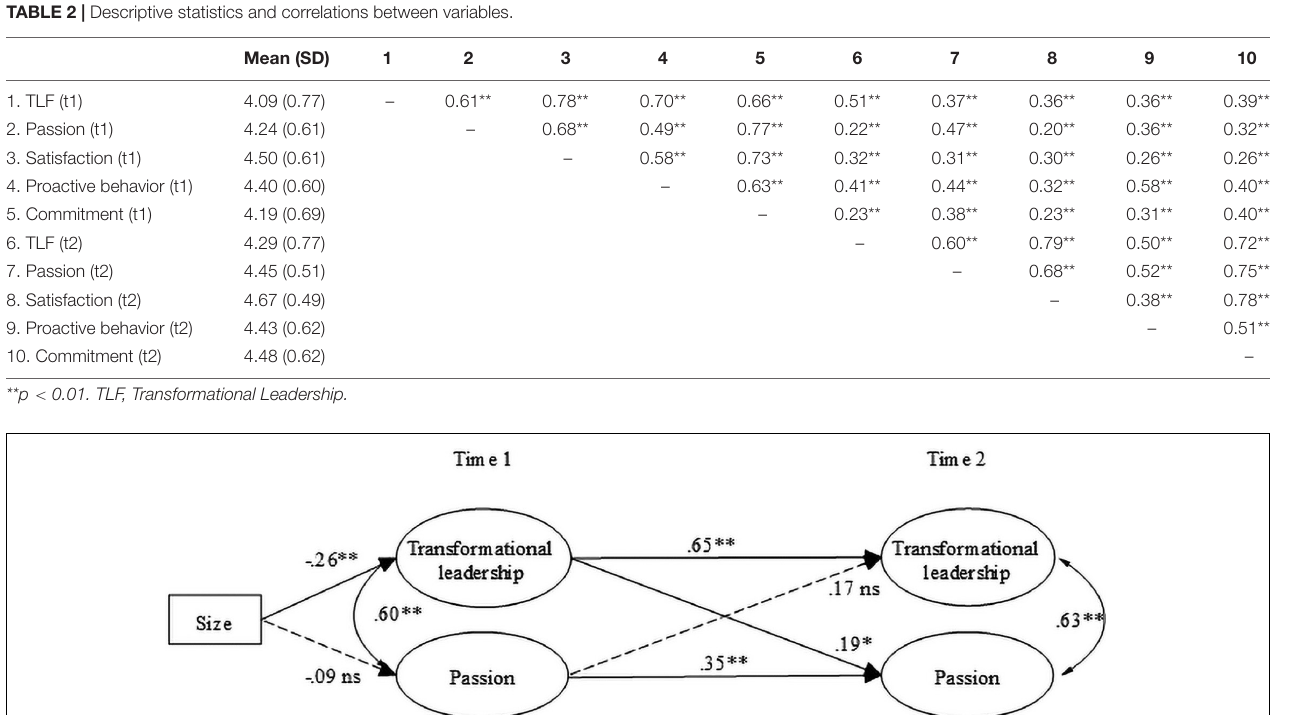
( β = 0.27 p < 0.01). Further, satisfaction and commitment at Time 1 showed a negative significative effect on proactive behavior at Time 2 ( β = − 0.22 p < 0.05; β = − 0.25 p <